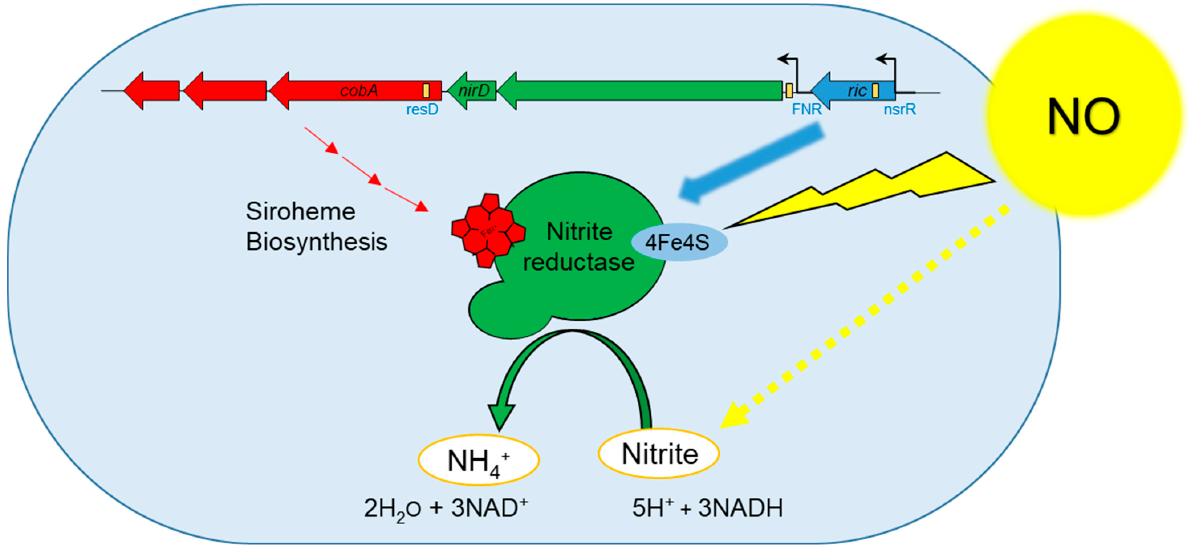
Figure 6. Model of Bacillus cereus response to NO. NO can be oxidized into nitrite and the nitrate reductase reduces this still toxic compound to ammonium. The green genes encode the two subunits of the nitrite reductase, which possesses an iron-sulphur cluster and requires a siroheme cofactor. The nitrate reductase genes are co-localized and co-expressed with, on one side, the three genes in red which encode proteins involved in the biosynthesis of siroheme, and on the other side, the ric gene in blue, which encodes a protein involved in iron cluster repair. Supplementary Materials: The following are available online at www.mdpi.com/xxx/s1, Table S1: RNA sample description; Table S2: List of genes influenced after 15 min of 10 µM NO stress.